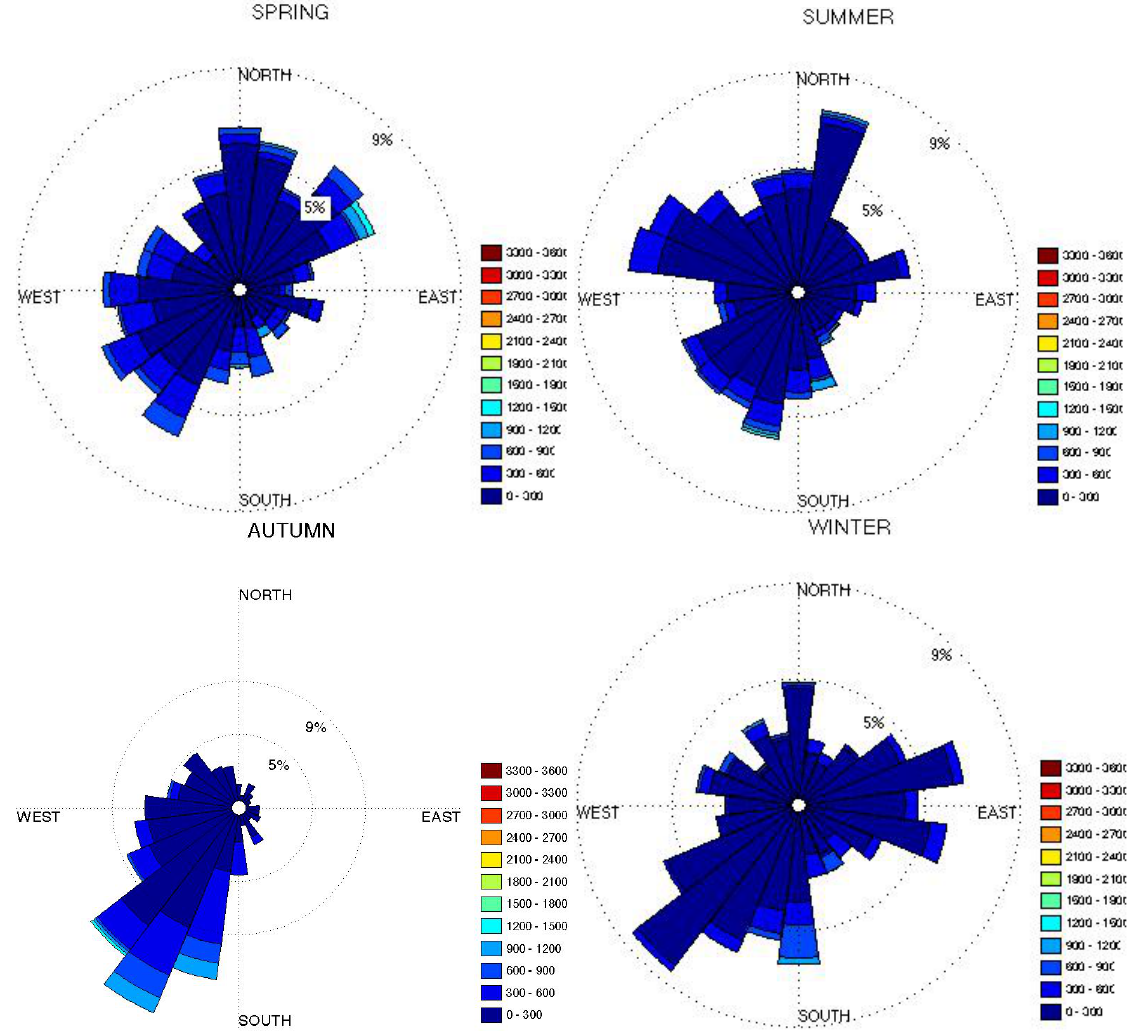
Fig. 11. The modelled seasonal wind directions (slices) and BC concentrations represented as a colour scheme (Hyyti¨al¨a